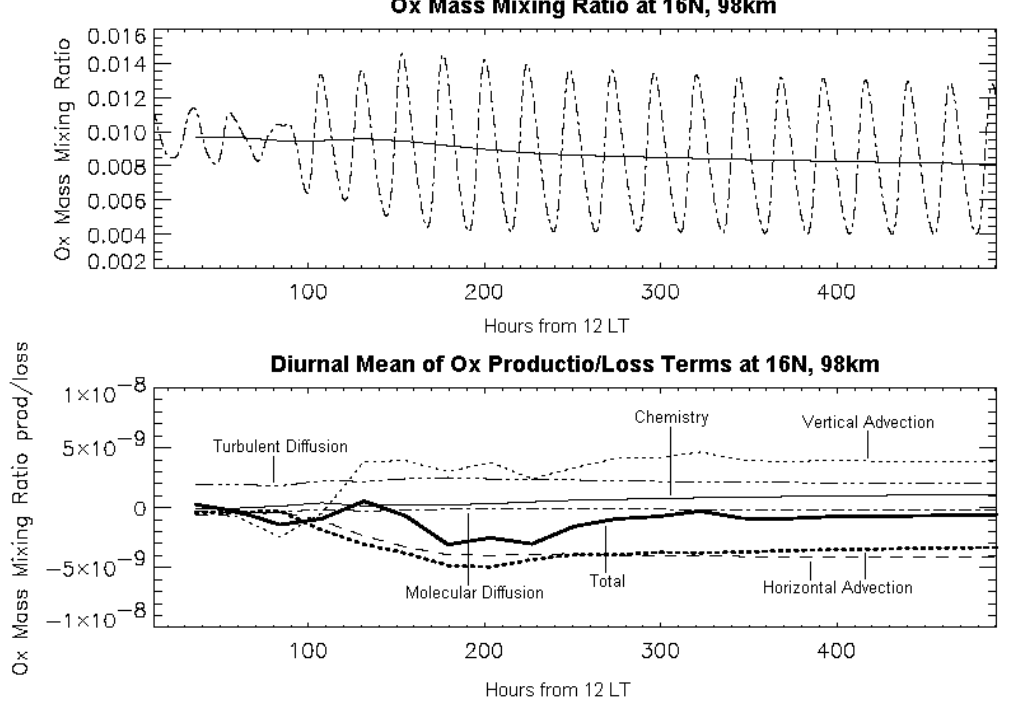
Fig. 12. (top): O x mass mixing ratio at 16 ◦ N, 98km, (dotted line), and diurnal mean of O x mass mixing ratio (solid line) as calculated by CMAT when introducing tides; (bottom) Diurnally averaged production and loss terms of O x at the equator for the same run and location.